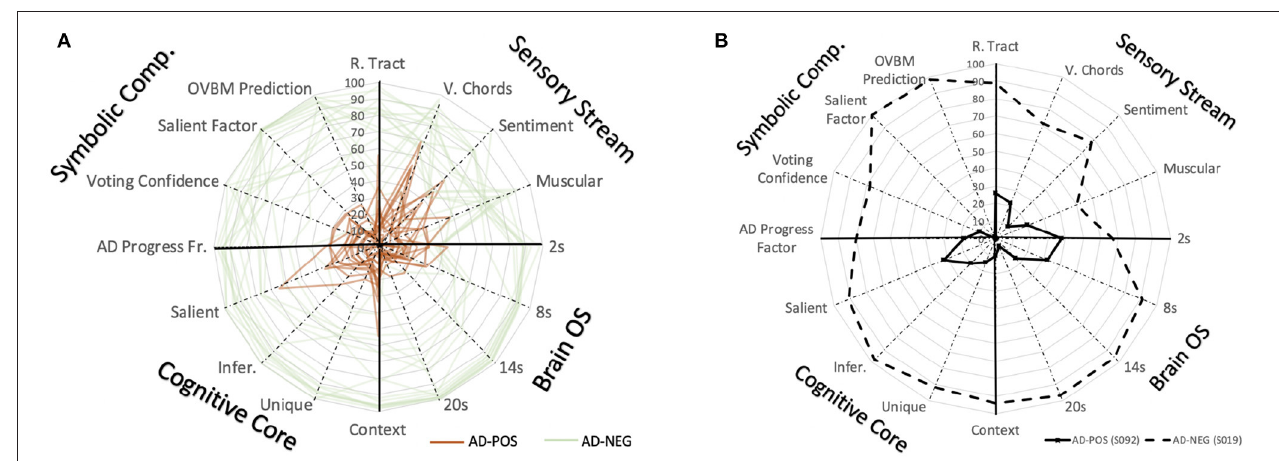
Frontiers in Computer Science |